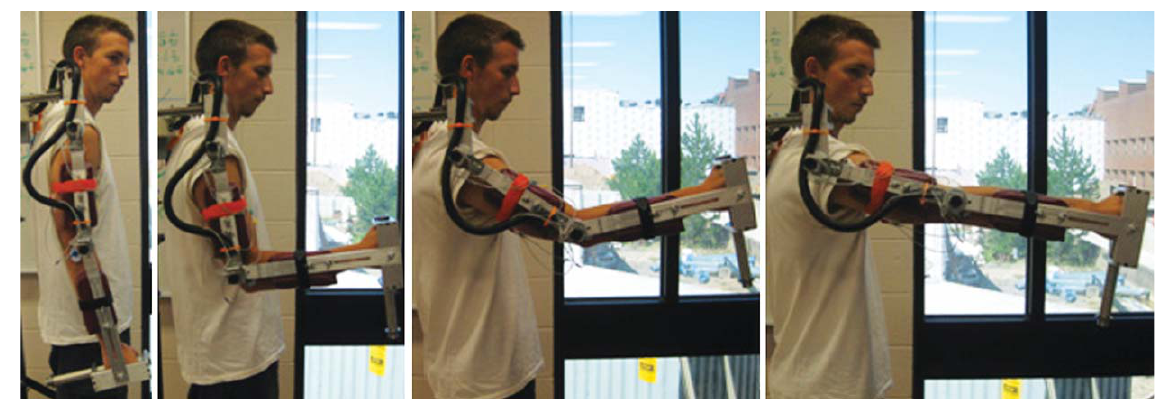
Fig. 6. Example of reaching motion involving motion in two degrees of